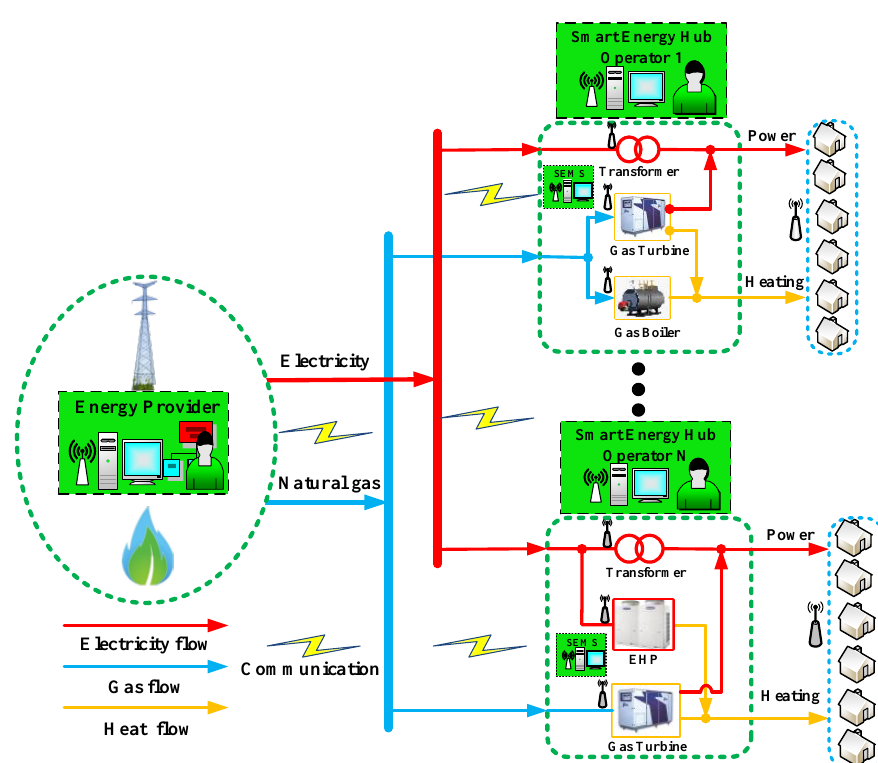
Figure 2. The schematic diagram of a smart integrated energy system consisting of one energy provider and N smart energy hub operators.